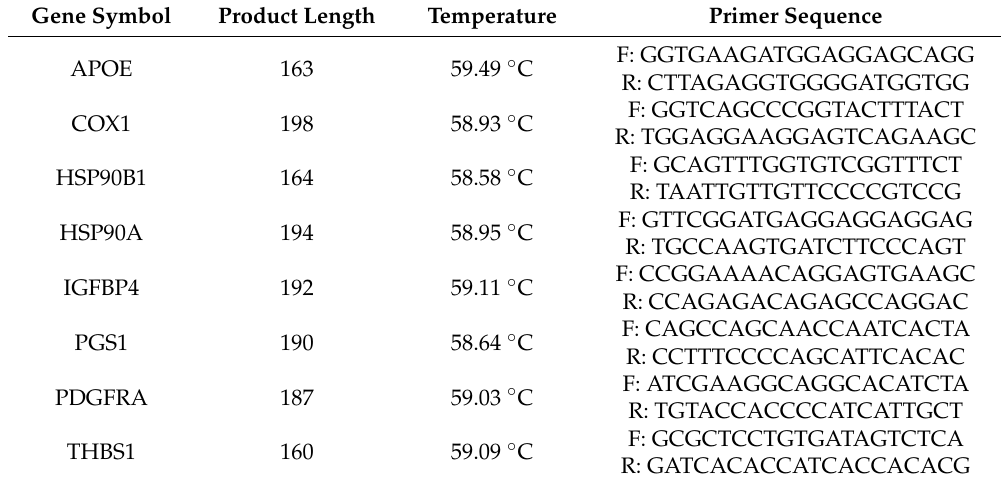
Table 3. Primer sequences used for